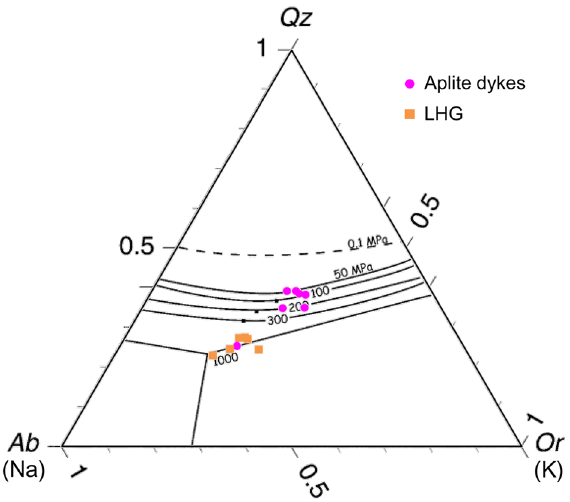
Figure 9. Depth of different magma sources: CIPW normative mineralogy (method of 90 ) from whole-rock XRF data for aplite dykes and LHG plotted on the H 2 O-saturated haplogranitic melt minima plot of 78 (after 77 ). Samples overprinted by intensive Na–Ca alteration are not plotted. Porphyry dykes plotted in Fig.